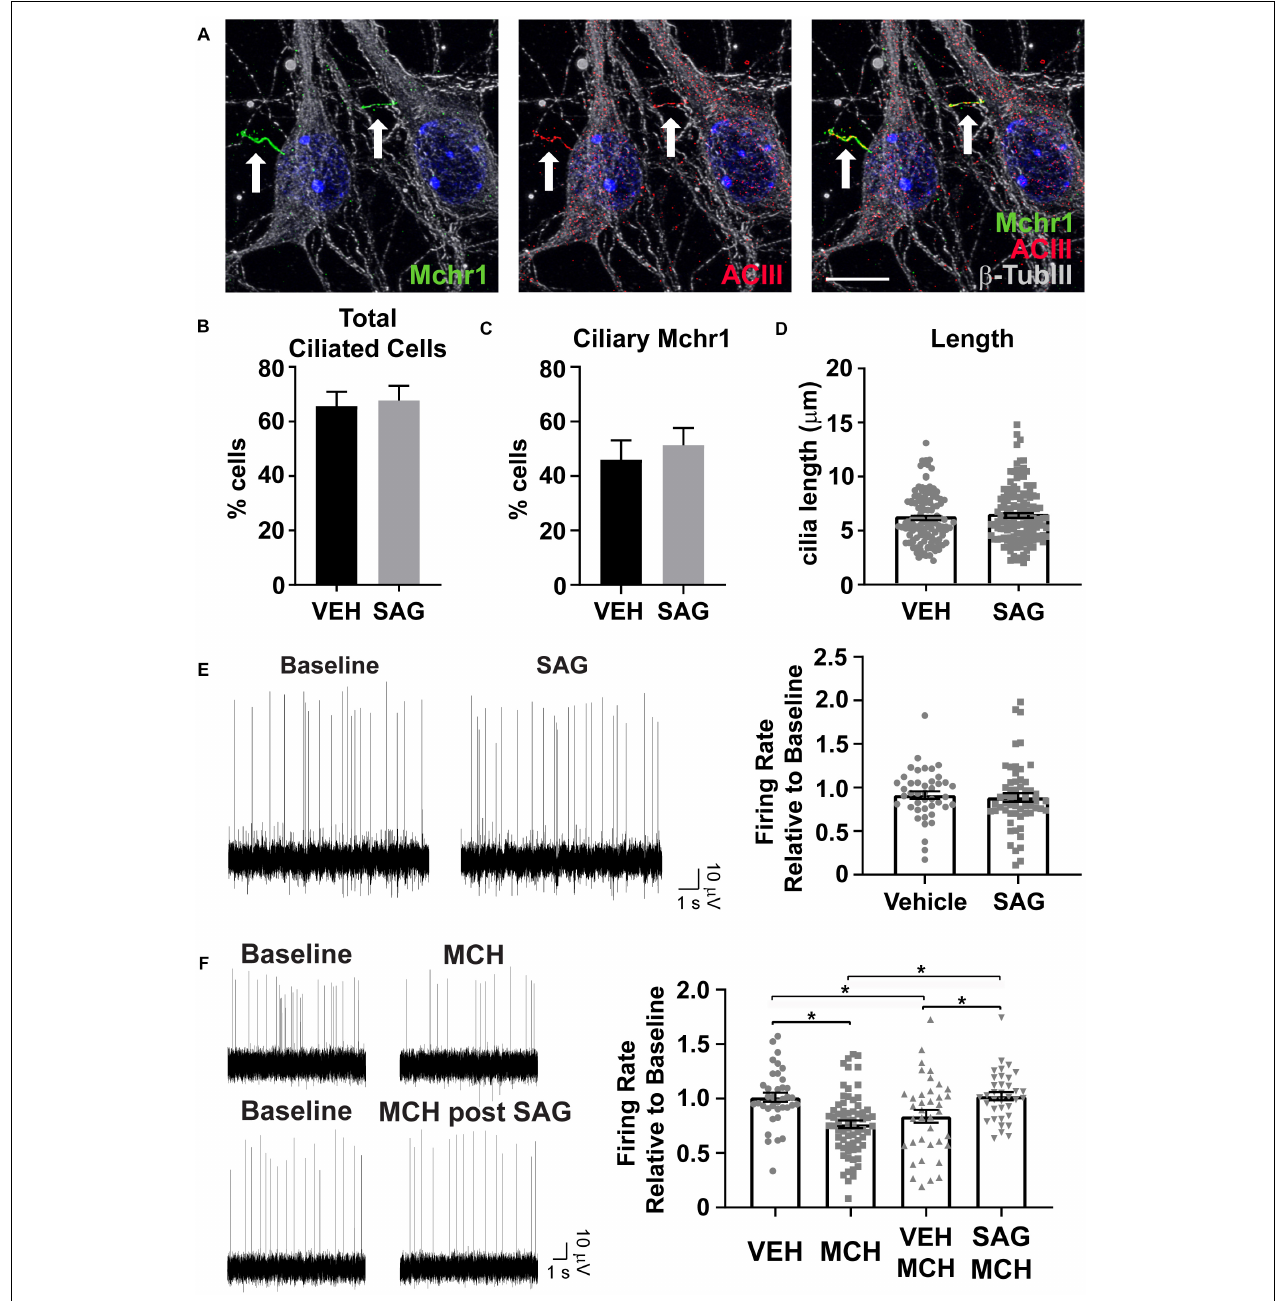
FIGURE 5 | Hedgehog pathway agonism attenuates neuronal response to MCH. (A) Melanin concentrating hormone receptor 1 (Mchr1, green) localizes to primary cilia (ACIII, red) of cultured hypothalamic neurons labeled with β -tubulin III ( β -TubIII, gray). Hoechst stained nuclei blue. Scale bar 10 µ m. Arrows indicate cilia. (B) Cilia counts in hypothalamic cultures following 24 h SAG treatment. Percent cilia positive cells in vehicle and SAG treated cultures is graphed as mean ± SEM. Vehicle treated hypothalamic cultures: 121 ACIII positive cilia/189 total cells. SAG treated hypothalamic cultures: 127 ACIII positive cilia/189 total cells. (C) Mchr1 positive cilia following SAG treatment. Percent Mchr1 positive cilia in vehicle and SAG treated cultures are graphed as mean ± SEM. Vehicle treated hypothalamic cultures: 83 Mchr1 positive cilia/121 ACIII positive cilia. SAG treated hypothalamic cultures: 96 Mchr1 positive cilia/127 ACIII positive cilia. (D) Cilia length measurements. Graphed as mean ± SEM. Outliers were identified and removed using ROUT with Q = 1%. 121 cilia were measured following 24 h vehicle treatment and 127 cilia were measured following 24 h SAG treatment. (E) Representative traces from one electrode showing baseline activity and activity after addition 400 nM SAG. The change in firing relative to baseline is graphed as mean ± SEM for vehicle and SAG addition. (F) Representative traces from one electrode showing baseline activity and activity after addition of 1 µ M MCH or MCH following 24 h pretreatment with 400 nM SAG. The change in firing relative to baseline is graphed as mean ± SEM for vehicle and peptide addition. Each point represents an active electrode. ∗ P < 0.05 using an Ordinary one-way ANOVA with Tukey’s multiple comparisons test. Outliers were identified and removed using ROUT with Q = 1%. All data collected from 3 to 6 hypothalamic samples from 3 to 5 experimental days.